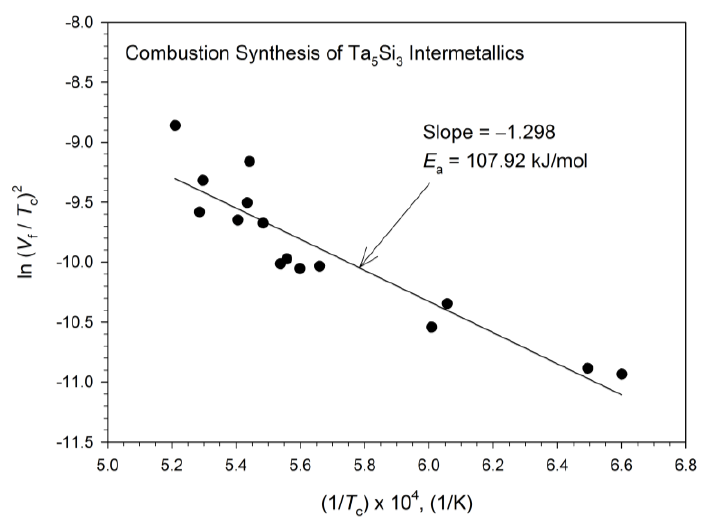
Figure 4. Activation energy ( E a ) of combustion synthesis of Ta 5 Si 3 determined from a relationship between combustion front velocity ( V f ) and temperature ( T c ).